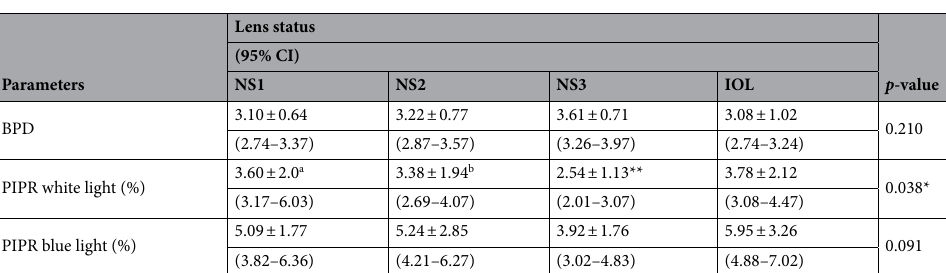
Figure 1. Representative pupillometry responses for the three grades of nuclear sclerosis (NS) after chromatic stimulus with white light ( a ), and blue light ( b ). Black bars represent stimulus duration. The vertical scale is expressed as % constriction from the baseline pupil diameter (BPD). ( a ) The responses obtained with white light show the initial transient constrictions followed by short-duration sustained constrictions. The more severe the grade of NS, the smaller the amplitude of pupil constriction observed. ( b ) For blue light, after the initial transient constrictions, the following sustained constrictions were stronger than those for white light. Smaller amplitudes of pupil constriction were observed in the more severe NS grades, as with white light.